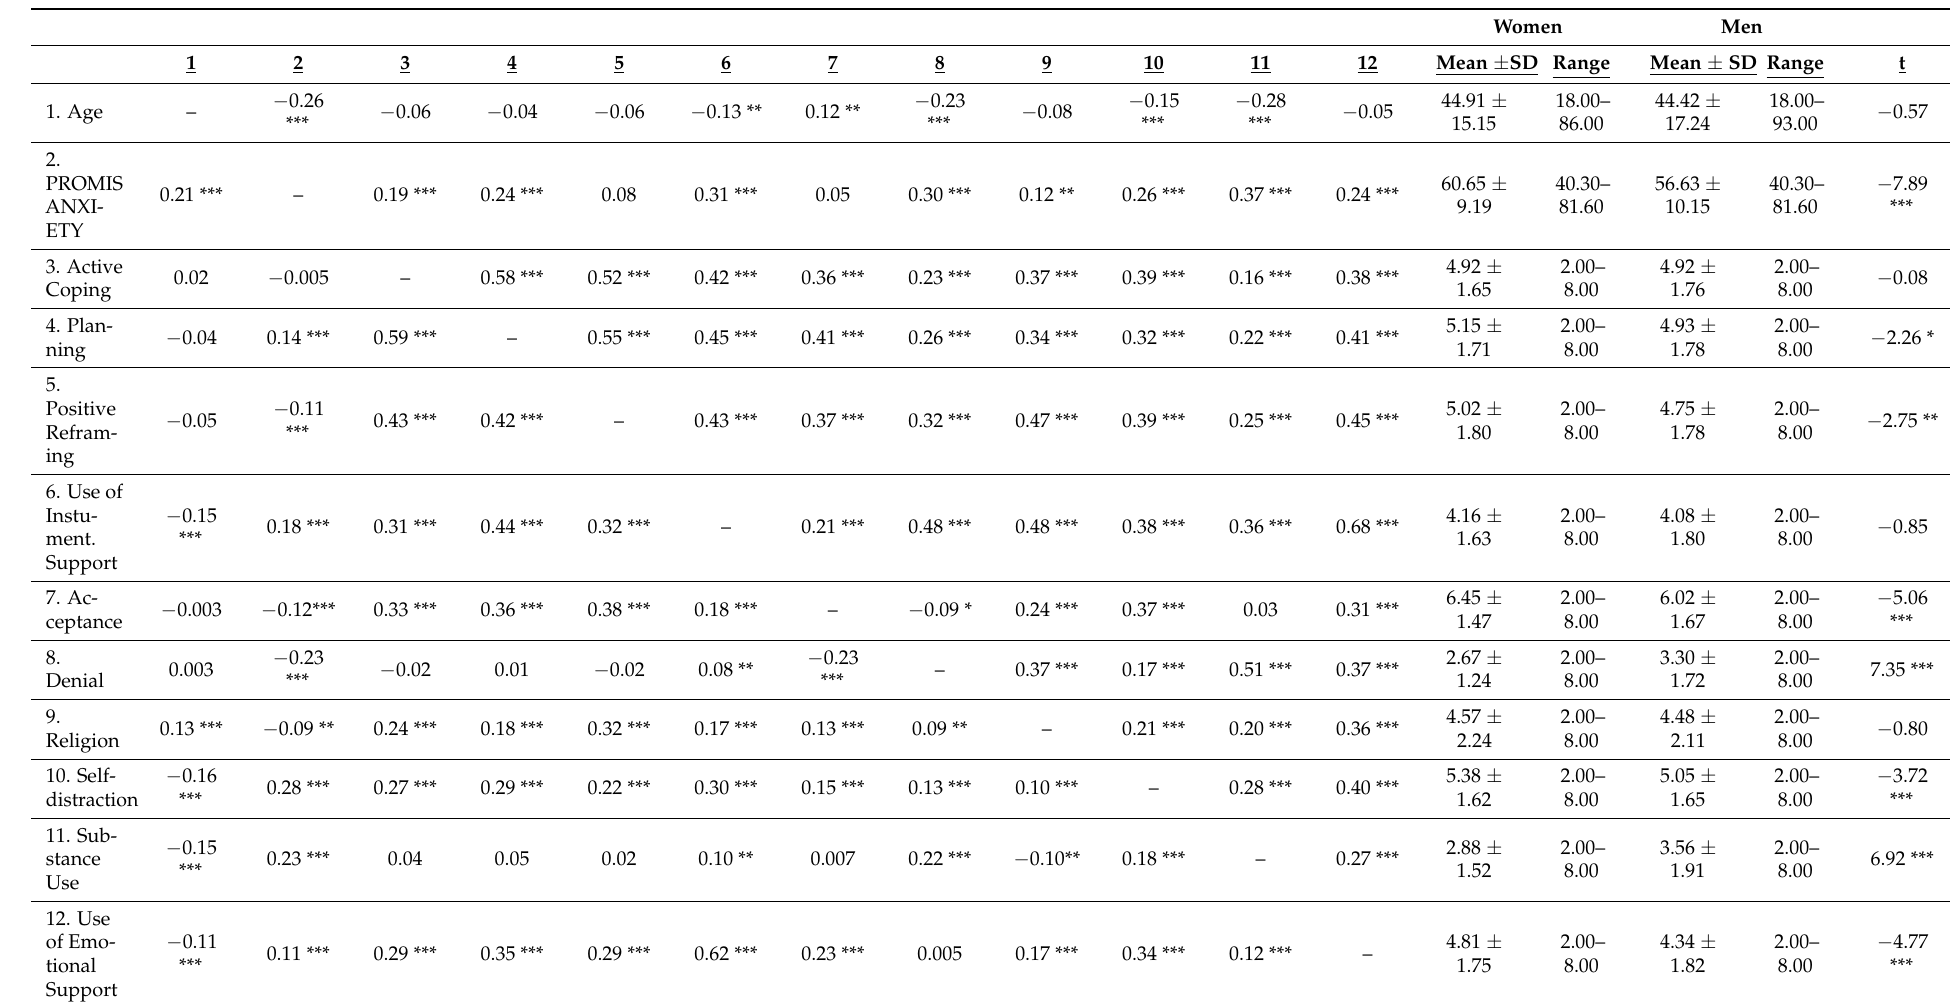
Table 2. Descriptive Results for Women and